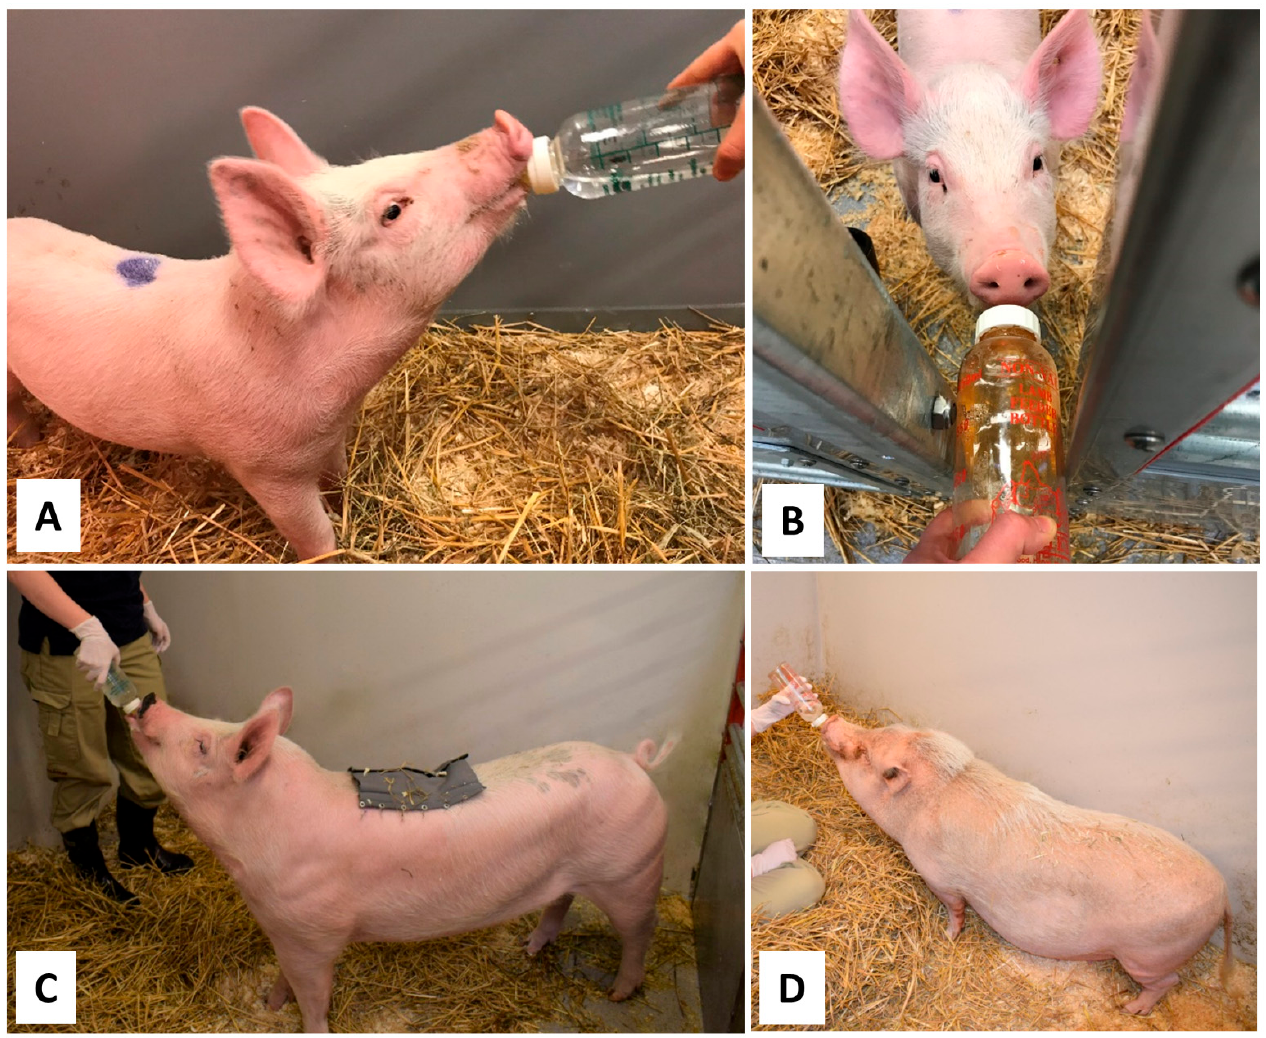
Figure 1. Bottle-feeding training of pigs prior to the oral glucose tolerance test. ( A ) Eight-week-old domestic pig, trained with glucose dissolved in water. ( B ) Eight-week-old domestic pig, trained with apple juice through the front of the pen. ( C ) Five-month-old domestic pig, trained with glucose dissolved in water. ( D ) Two-year-old Göttingen minipig, trained with glucose dissolved in water.